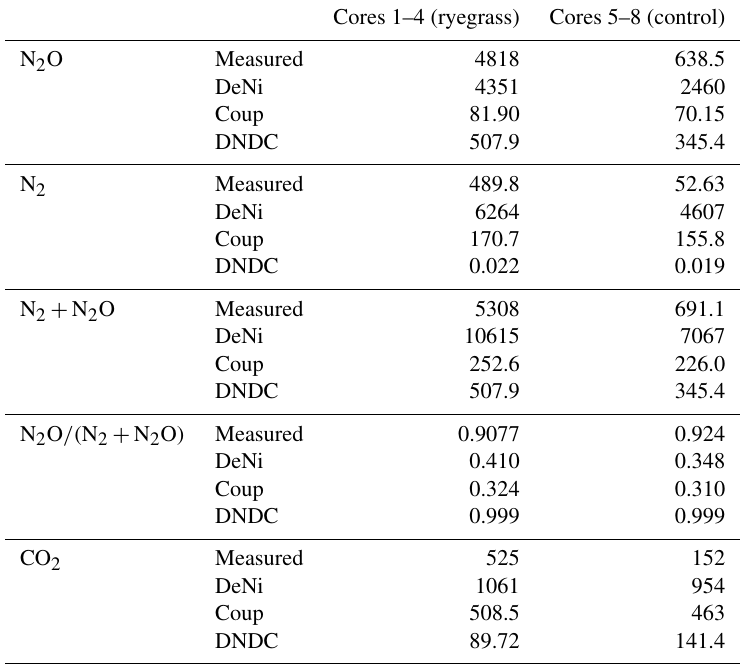
Table 5. The measured and modeled (Coup, DeNi, DNDC) average, cumulative N 2 , N 2 O and N 2 + N 2 O, CO 2 fluxes (gNha − 1 and kgCha − 1 ), and product ratios (dimension less) for sand arable soil from Fuhrberg, Germany. C1–4 represent the first four parallel columns for the ryegrass treatment. C5–8 represent the four parallel columns of the control/non-ryegrass